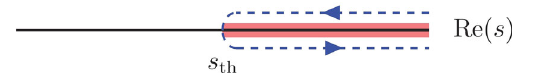
Fig. 6 Trajectory of s 12 − on the second sheet with m ∗ increases from 2.368 GeV to 2.858 GeV